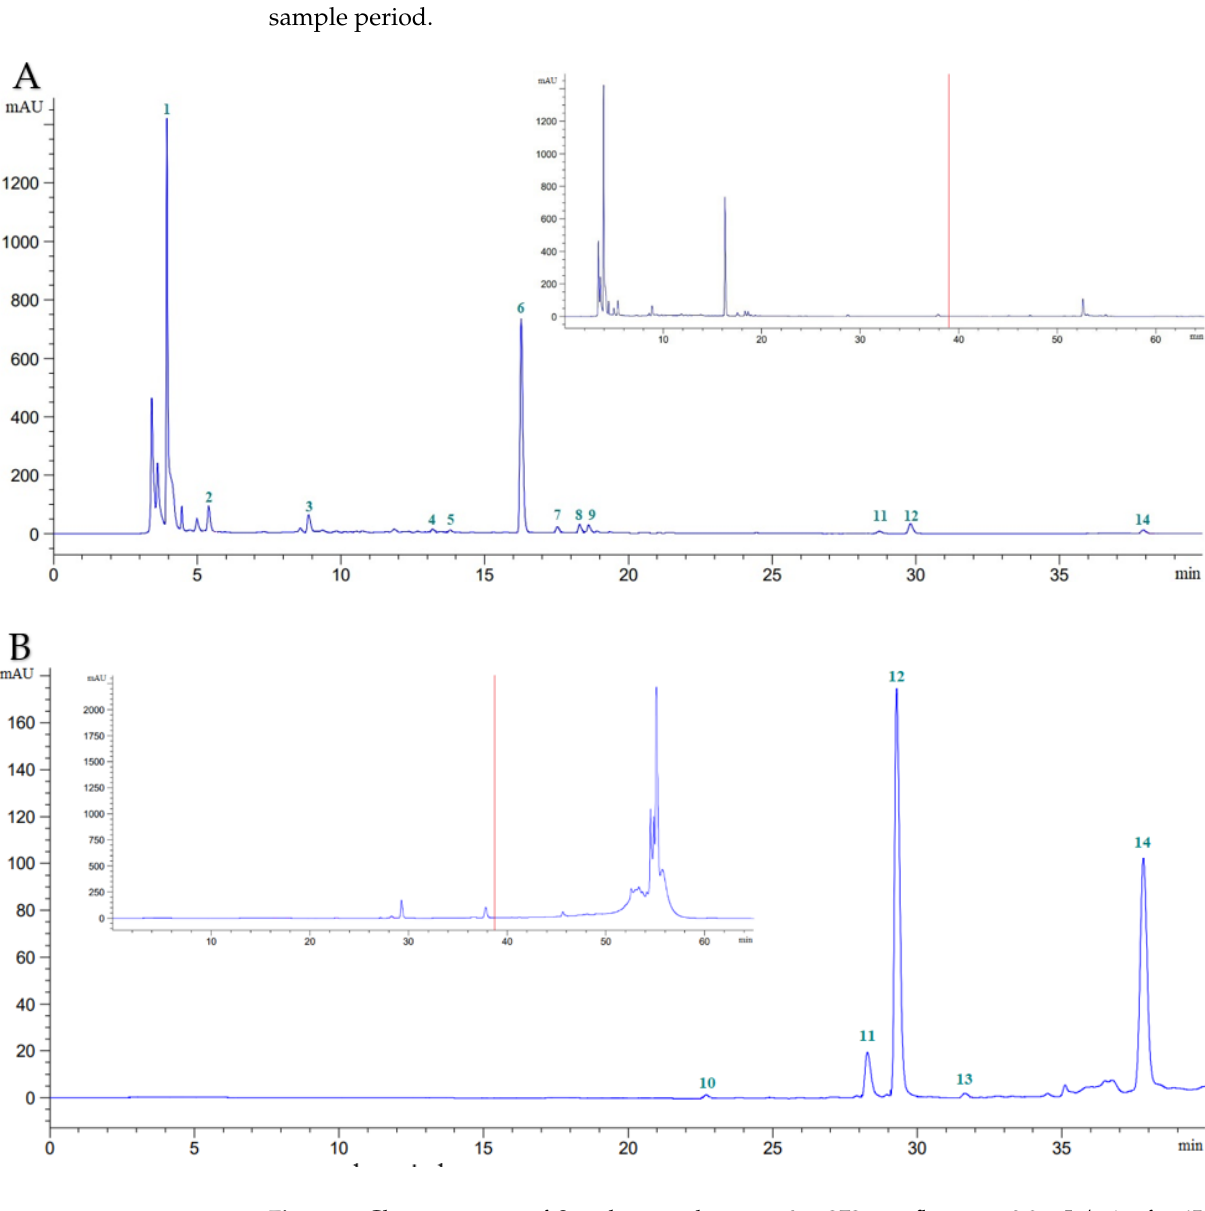
Figure 1. Chromatogram of S. androgynus leaves at λ = 272 nm, flow rate 0.9 mL/min, for 65 min. ( A ), methanolic extract (20 × dilution); ( B ), hexanoic extract (20 × dilution). Peak 1, ascorbic acid; 2, gallic acid; 3, catechin; 4, caffeic acid; 5, syringic acid; 6, rutin; 7, p -coumaric acid; 8, sinapic acid; 9, ferulic acid; 10, myricetin; 11, quercetin; 12, apigenin; 13, kaempferol; 14, eugenol. Table 1. Identifying and quantifying selected phytochemicals in methanolic and hexanoic extracts of commercial and noncommercial S. androgynus leaves.